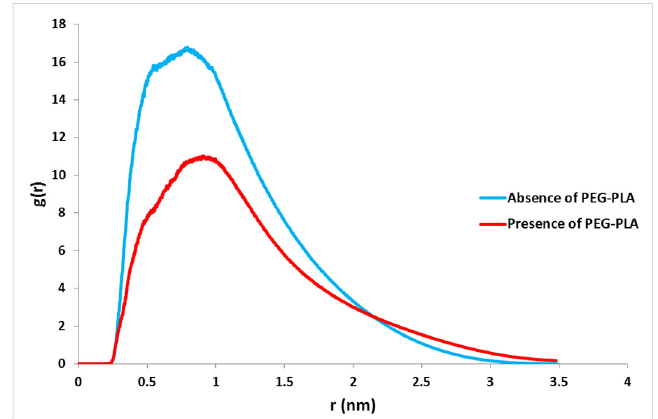
Figure 5. RDF of the docetaxel anticancer drug loading onto graphene quantum dot oxide in the presence and absence of the PEG-PLA copolymer over 50 ns MD trajectories.